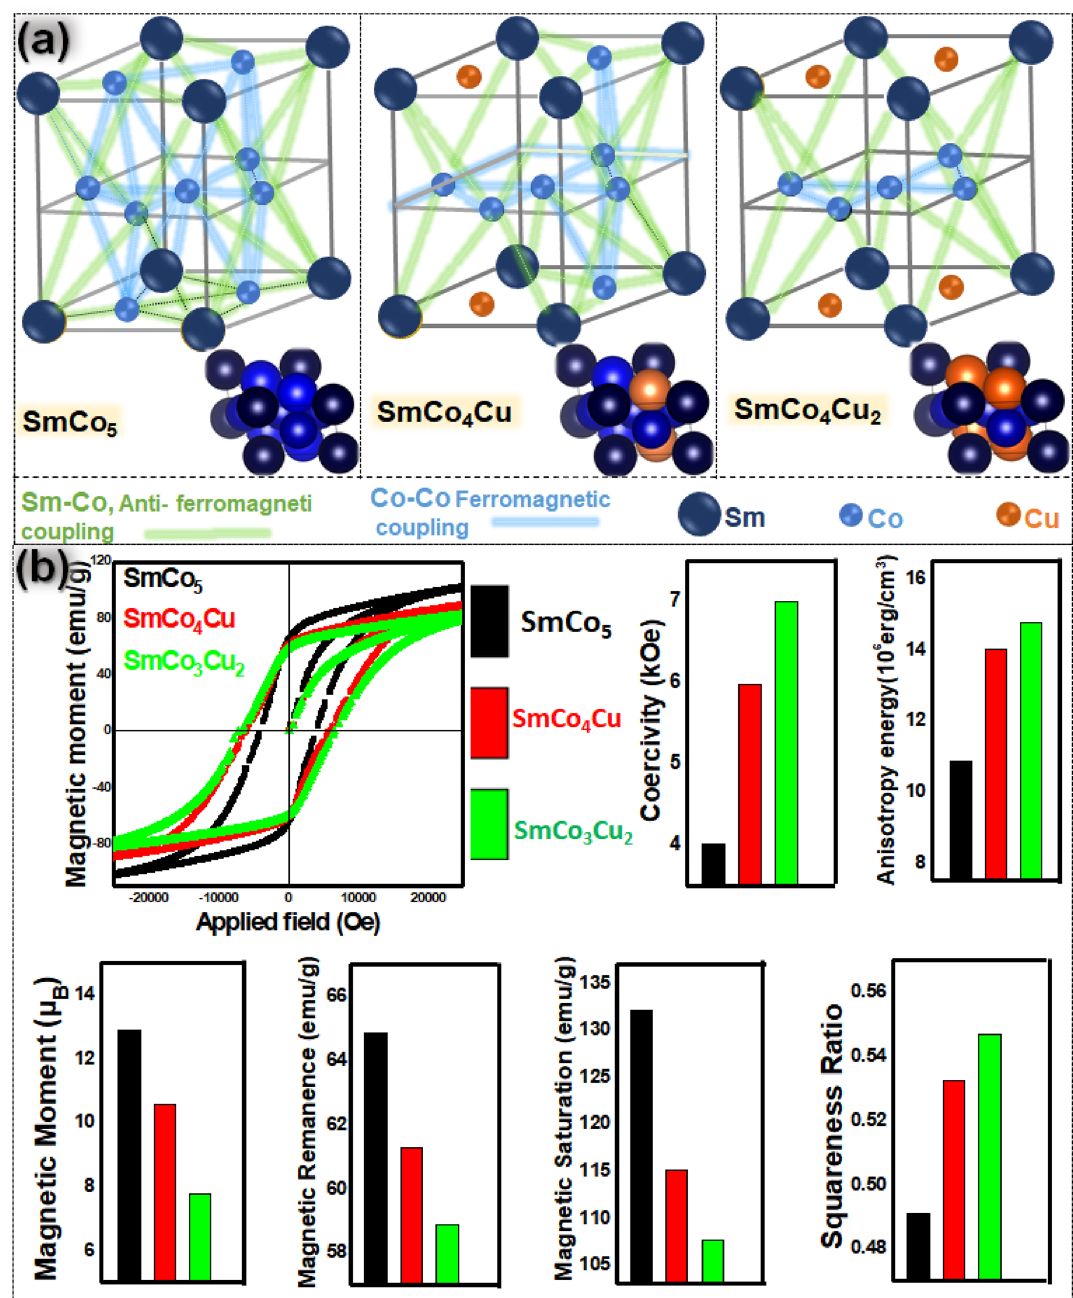
Figure 6. ( a ) Mechanism on the reduction of exchange coupling before and after Cu substitution in SmCo 5 and SmCo 5−x Cu x . ( b ) Magnetic hysteresis loops of SmCo 5 and SmCo 5−x Cu x . Variation of magnetic moment, H c , M r , M s and anisotropy energy, before and after Cu